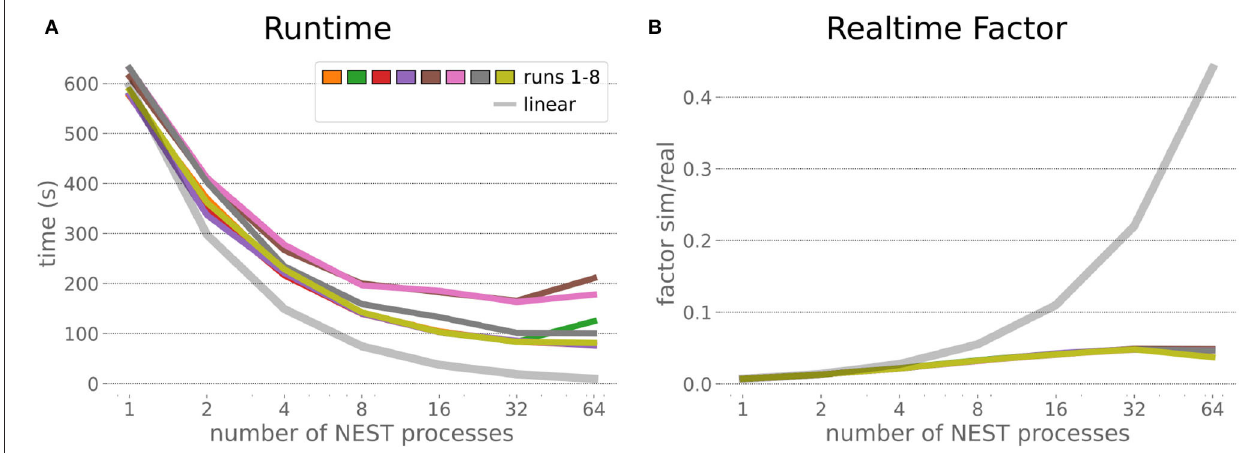
FIGURE 10 | Embodied multi-region rodent brain benchmark runtime and realtime factor. Experiment runtime (A) shows a variability in repetitions, but can be improved exponentially by a factor of about 6 when scaling up to 64 NEST processes. The realtime factor (B) can be improved up to about 0.048, but starts saturating from 32 NEST processes